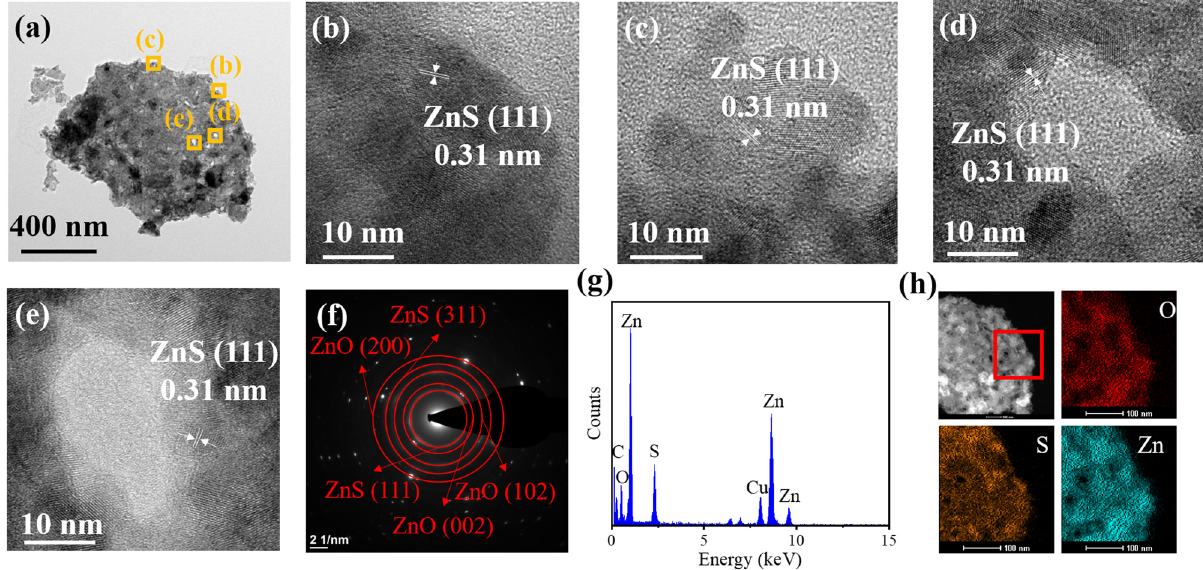
Figure 3: TEM analysis of the ZS - 1: ( a ) low - magni fi cation image. ( b ) – ( e ) HRTEM images of various local regions in image ( a ) . ( f ) SAED pattern. ( g ) EDS spectrum. ( h ) Elemental mapping